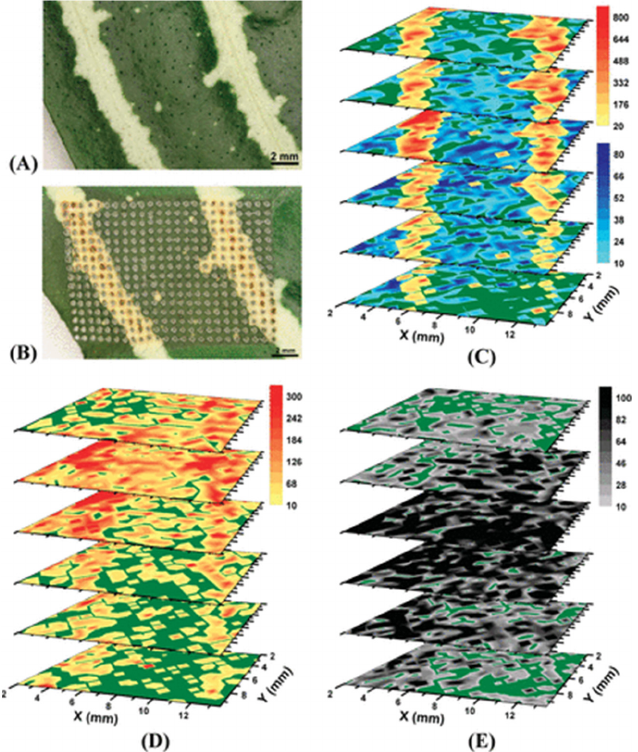
Figure 5. LAESI 3D imaging MS of A.squarossa leaf tissue where metabolites in relation to tissue architecture captured. Optical image of A. squarrosa leaves ( a ) before and ( b ) after analysis; ( c ) LAESI architecture captured. Optical image of A. squarrosa leaves ( A ) before and ( B ) after analysis; ( C ) LAESI 3D imaging MS distribution of kaempferol/luteolin with m/z 287.0 (yellow/orange scale) followed the variegation pattern. Chlorophyll a with m/z 893.5 (blue scale) accumulated in the mesophyll 3D imaging MS distribution of kaempferol/luteolin with m / z 287.0 (yellow/orange scale) followed layers; ( d ) Acacetin with m/z 285.0 showed higher abundance in the yellow sectors of the second the variegation pattern. Chlorophyll a with m / z 893.5 (blue scale) accumulated in the mesophyll and third layers with a homogeneous distribution in the others; ( e ) Kaempferol-(diacetyl coumaryl- rhamnoside) with m/z 663.2 accumulated in the mesophyll layers (third and fourth) with uniform layers; ( D ) Acacetin with m / z 285.0 showed higher abundance in the yellow sectors of the second lateral distributions. Figure reproduced with permission from Nemes et al. [34]. and third layers with a homogeneous distribution in the others; ( E ) Kaempferol-(diacetyl coumaryl- rhamnoside) with m / z 663.2 accumulated in the mesophyll layers (third and fourth) with uniform lateral distributions. Figure reproduced with permission from Nemes et al.